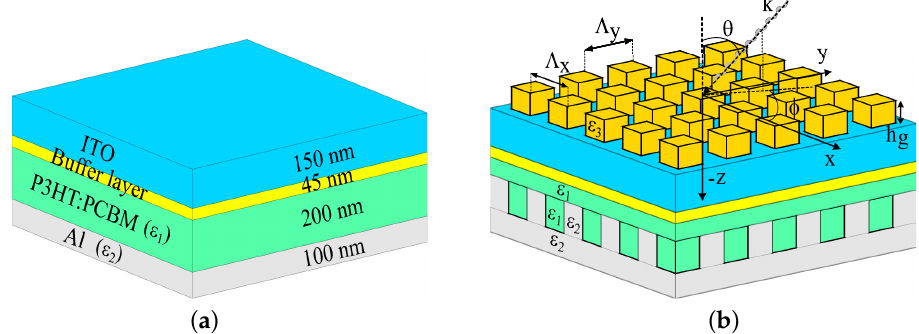
Figure 2. ( a ) The typical organic solar cell structure (the reference structure) consists of smooth layers. ( b ) Structure C: based on the reference organic solar cell structure with front and back grating